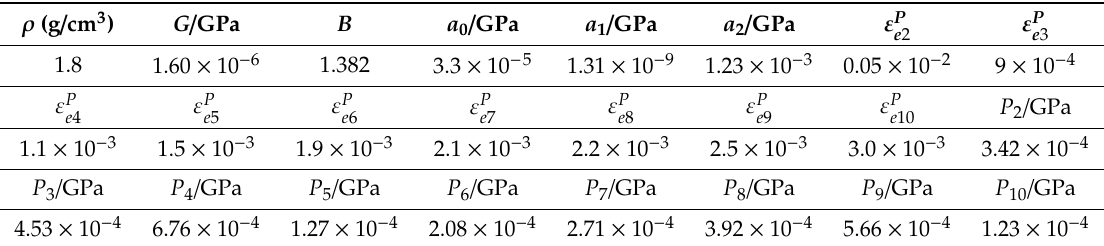
Table 6. Parameters of the soil [43].